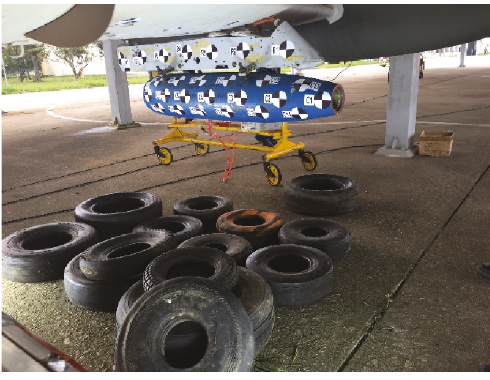
Figure 4: Store installed on the pylon. Tires for cushioning placed on the